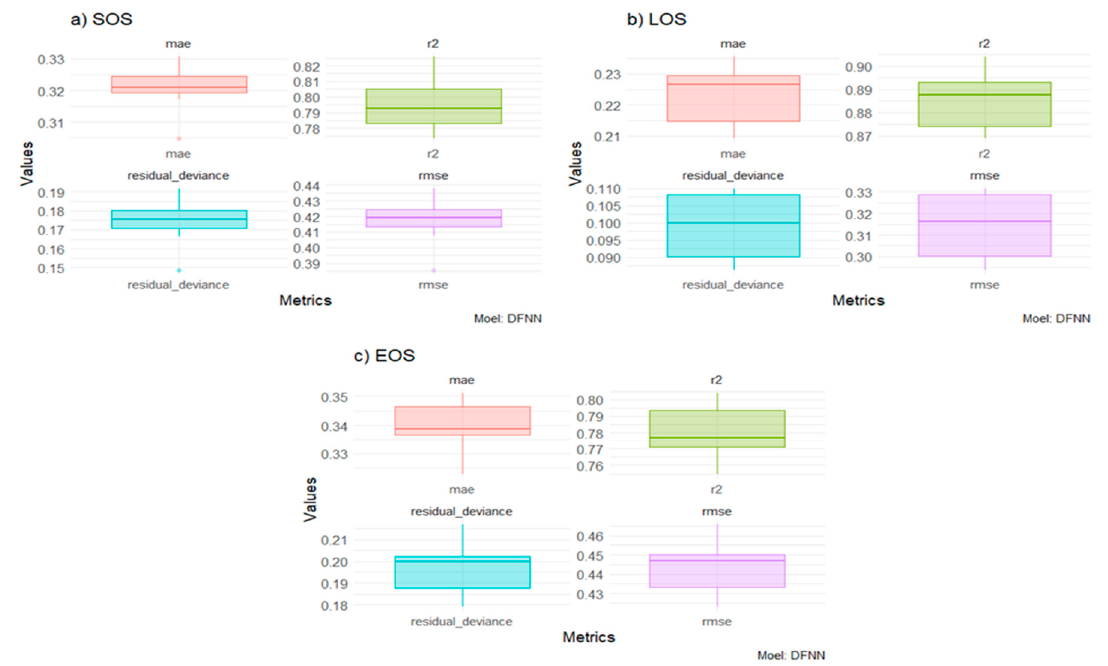
Figure 5. Cross-validation metrics of deep learning model showing the validation performance for each phenology stage.